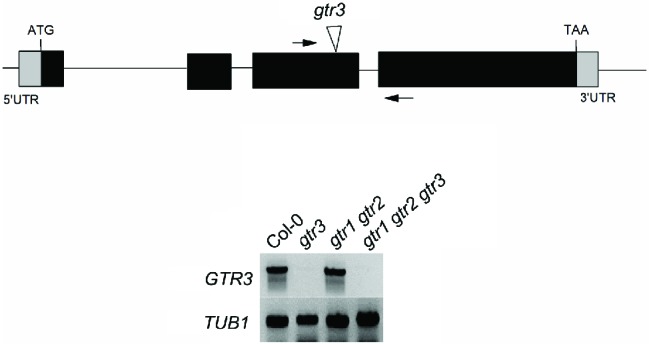
Validation of gtr3 T-DNA insertion mutants.Genomic location of T-DNA insertion in gtr3. Arrows indicate location of RT-PCR primers. RT-PCR analysis on RNA isolated from wild type Col-0, gtr3, gtr1 gtr2, gtr1gtr2 gtr3 using GTR3-specific primers. TUB1 (AT1G75780)-specific primers were used as internal control. See Supplementary Materials and methods for primer sequences.